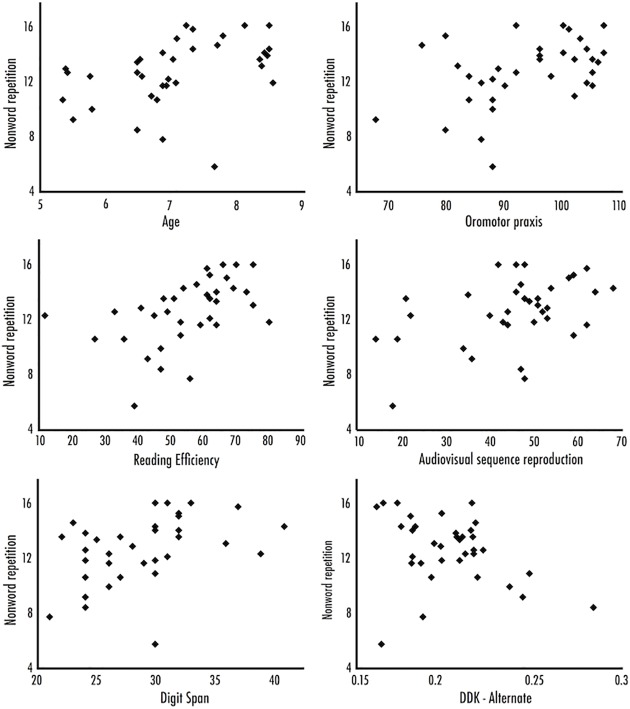
Scatterplots depict the relationship between raw nonword repetition scores and each of the predictors.Predictors include age; reading efficiency; digit span trials correct; oromotor praxis; total audiovisual sequence reproduction score and alternating DDK rate.